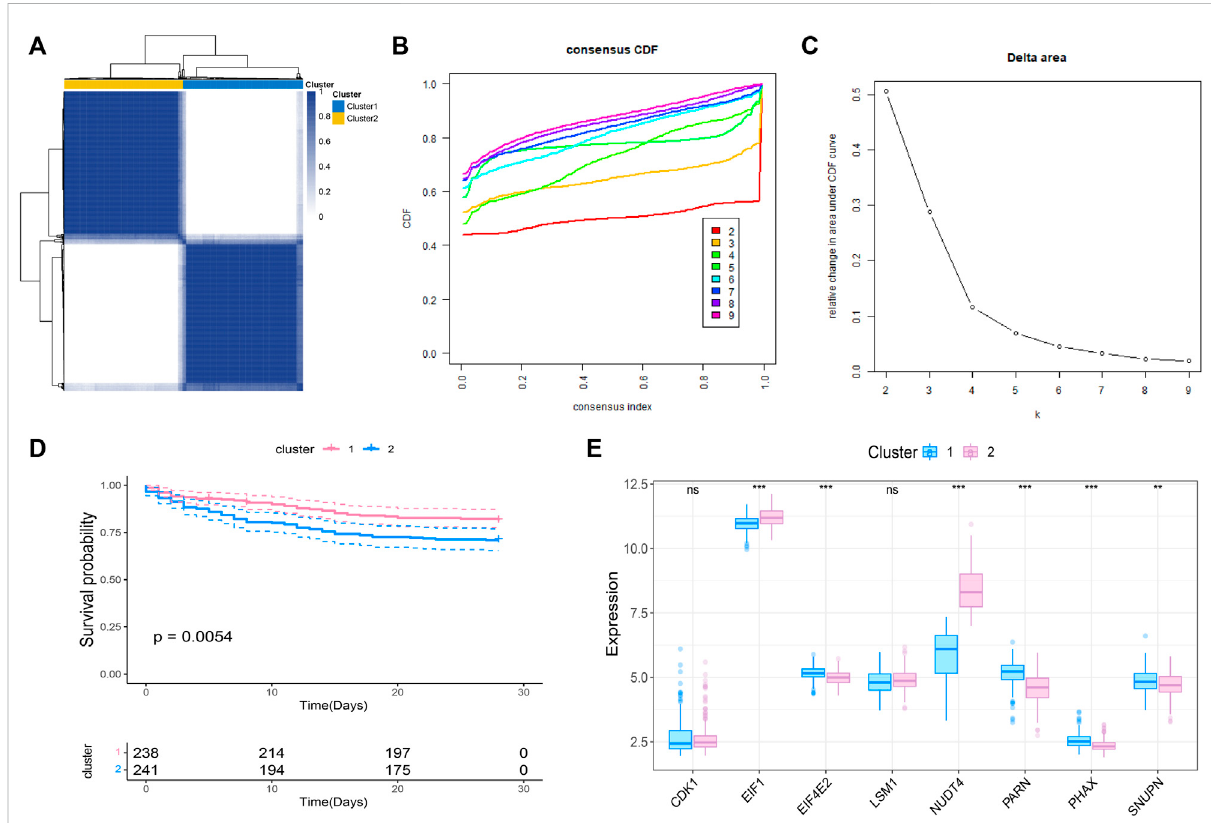
FIGURE 2 Molecular classi fi cation of sepsis based on m7G-related prognosis genes. (A) Consensus clustering heatmap: when k = 2, the clustering of samples is relatively stable. (B) The cumulative distribution function (CDF) curve. (C) The delta area score displays the survival curves of these two subtypes ( k = 2) with the relative increase of cluster stability (D) . Kaplan-Meier curve showed the statistical difference between these two subtypes ( p < 0.0001), and the prognosis of patients within Cluster 2 was poor. (E) Expression pro fi le of m7G gene in the two